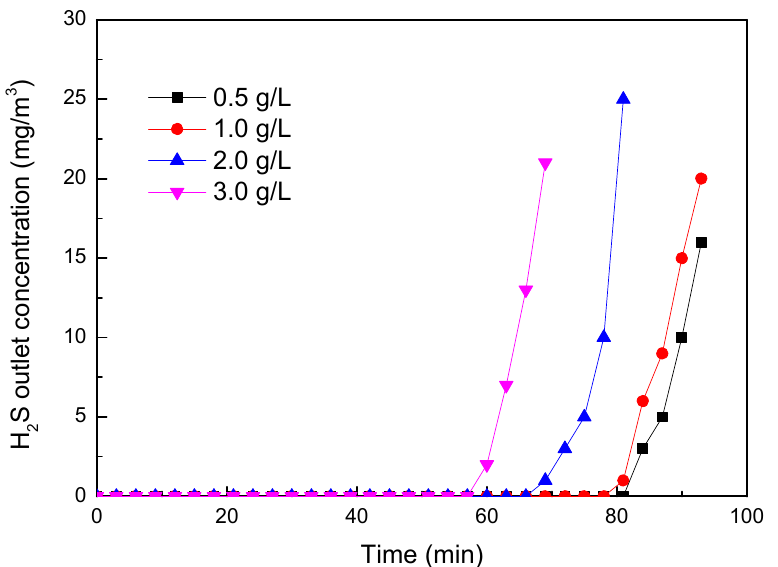
Figure 7. The breakthough curves of hydrochar S5C5 with cationic PAM of different concentrations (T, 230 °C; auxiliary agent, cationic PAM).